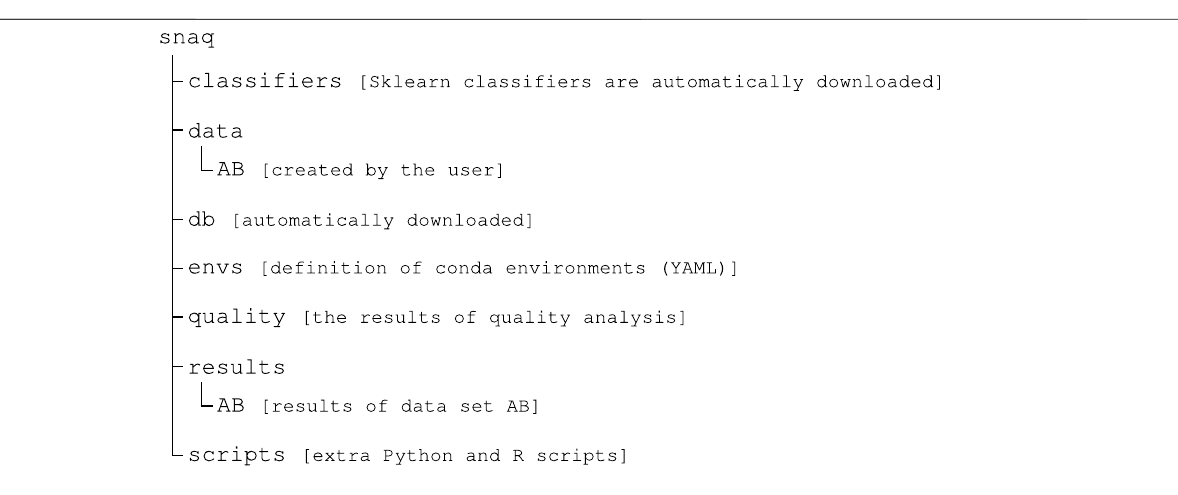
FIGURE3| Folder structure ofSnaq afterinstallation(classi fi ersandqualityfolderswillbecreated atlaterstageifrequired).Contentsofdataandresultsfolderswill vary according to use after installation. Notice that all data sub-folders need to be named using capital